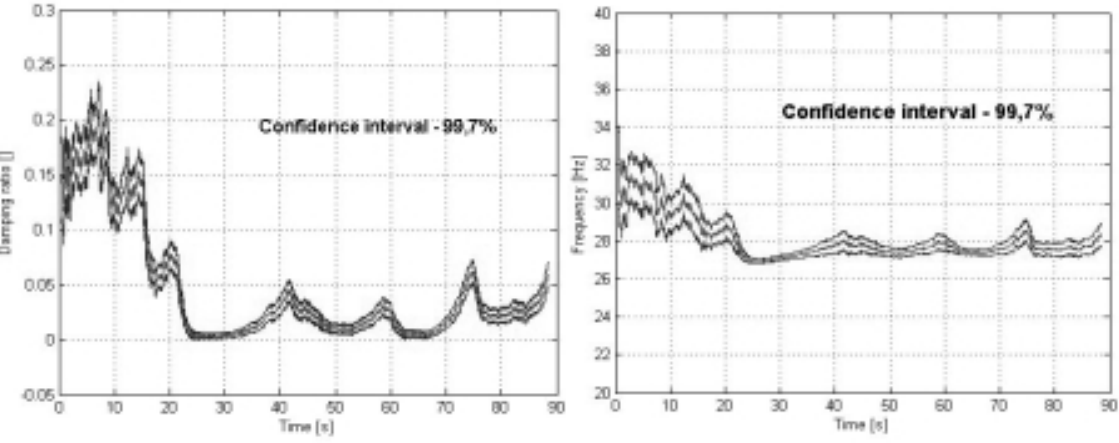
Fig. 6. Confidence intervals for modal parameters a) damping ration b) natural